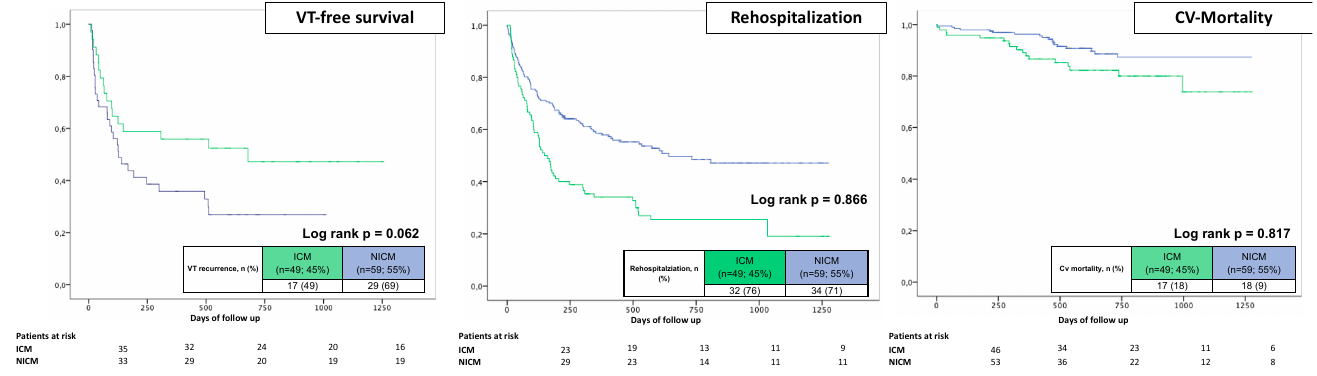
Figure 2. Prognostic impact of ES on VT recurrences ( left panel), rehospitalization rates ( middle panel) and cardiovascular mortality ( right panel).